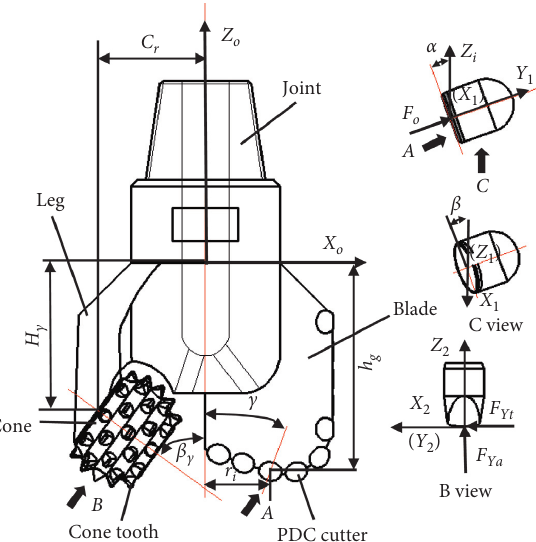
Figure 6: PDC-cone composite bit working load analysis